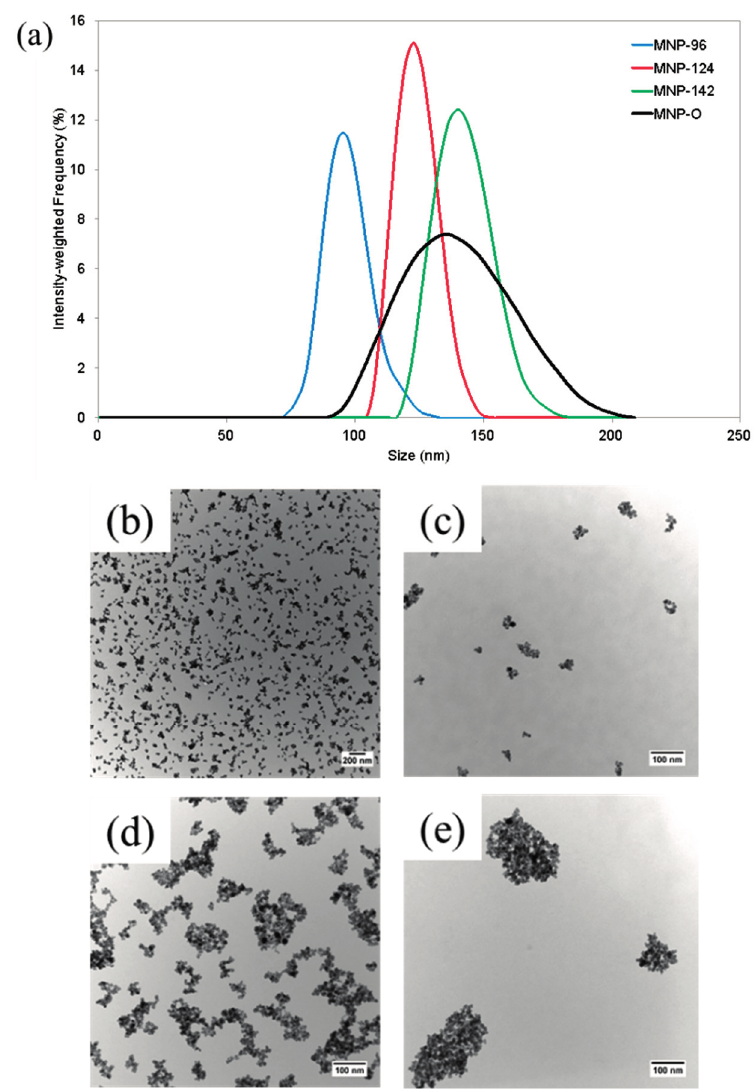
Figure 5. ( a ) Size distributions obtained from the original nanoparticle suspension (MNP-O) at flow rates of 10 mL/min (MNP-96), 40 mL/min (MNP-124), and LO (MNP-142); ( b ) Representative TEM image at 12.5 K magnification of original nanoparticle suspension, MNP-O, before separation; ( c – e ) Representative TEM images of MNP-96, MNP-124, and MNP-142 particle samples, respectively, at 85 K